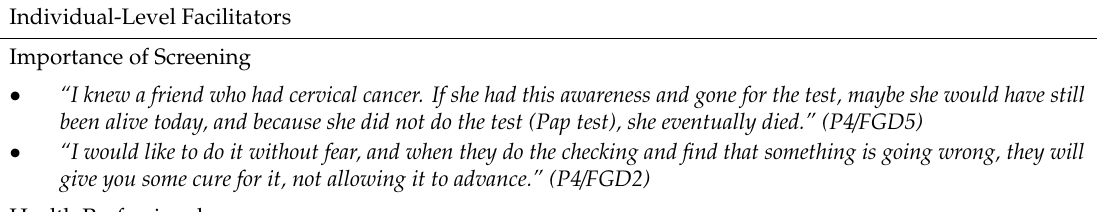
Table 4. Examples of quotations of facilitators to CCS